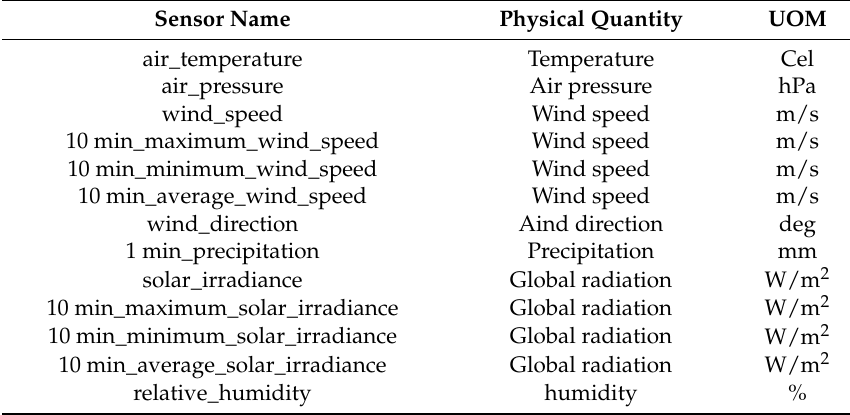
Table 3. Sensor name, physical quantity and